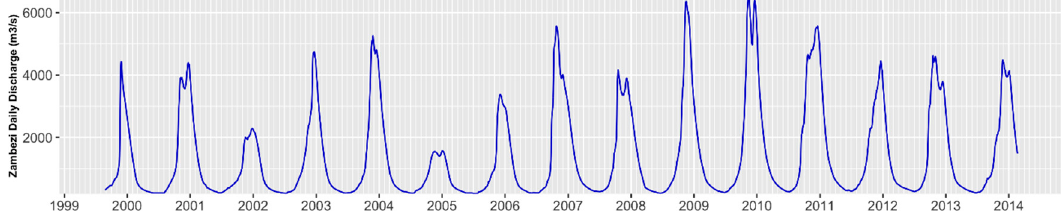
Figure 3. Time series of daily discharge of the Zambezi River collected at the Katima Station from 2000 to